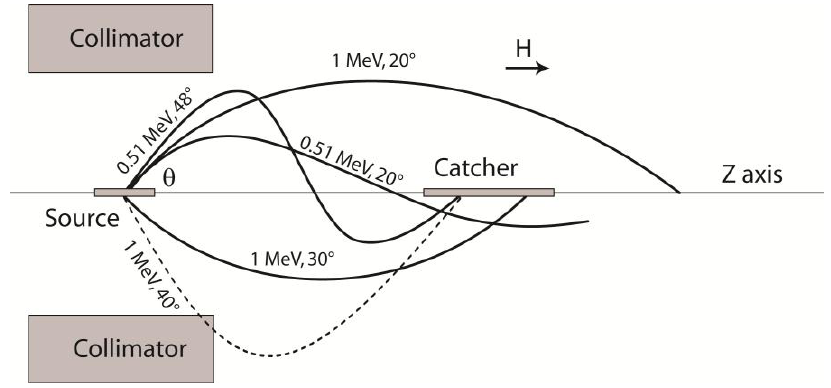
Figure 2. Experimental apparatus used by Greenberg and Deutsch for the detection of positrons emitted from a 90 Y source due to 1.75 MeV electric monopole transition to 90 Zr. Image reproduced from reference [4].